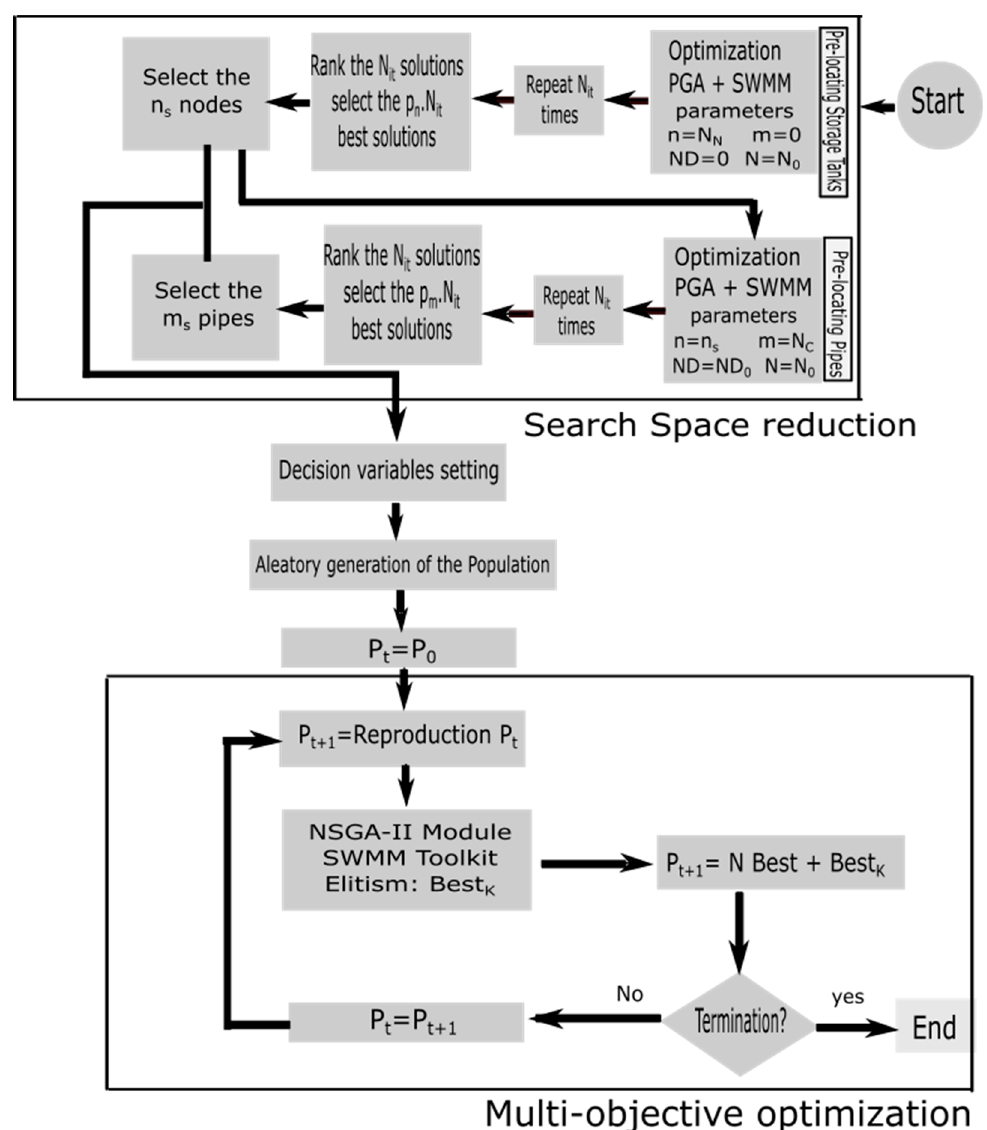
Figure 1. Flow chart of the presented methodology.